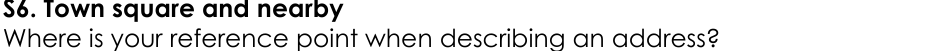
Table 5. Percentage (%) distribution for participants’ preference of reference point when describing an address in the city square and its immediate surroundings.